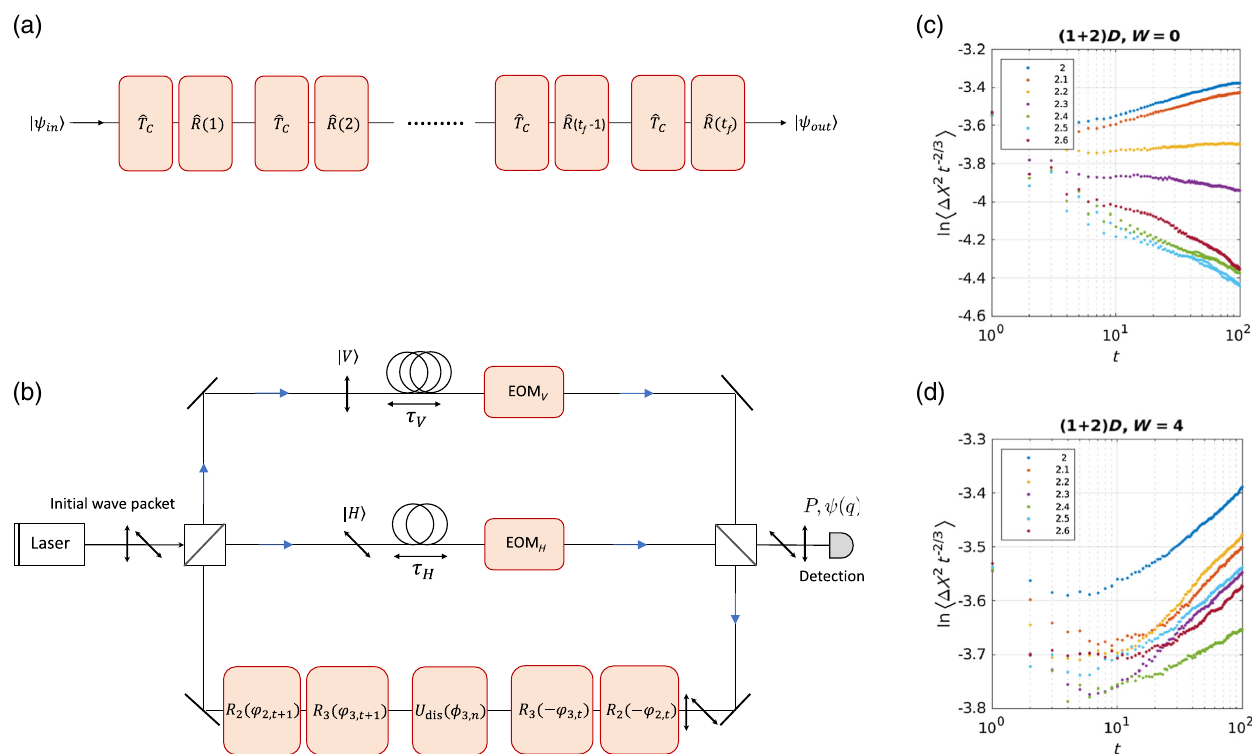
FIG. 3. (a,b) Blueprint of an optical linear network simulating the topological surface states of a 4 D quantum Hall insulator in the quantum-walk setting. The feedback loop is built of the step operator ˆ R ˆ U R † (lower arm) — for details, see main text. To the left and right of the loop, source and detection units are connected. ð t Þ ¼ R t t dis þ 1 The source consists of a laser and a polarizing beam splitter (PBS), allowing for the preparation of the initial state. The passage to the detection unit can be activated by the dynamically tunable EOMs following the fiber lines of the step operation. In the detection unit, photons are registered by an avalanche photodiode (APD). (c,d) Numerical simulations of wave-packet spreading for trivial and topological quantum walks, here for varying incommensurate frequencies. The latter are chosen as ω 2 ¼ C several values 2 . 0 ≤ C ≤ 2 . 6 (see legends). Differences between the two systems become visible already after t ≳ 10 time steps: The topological metal (d) shows robust diffusion for all values of C , while a crossover from diffusive to subdiffusive dynamics is observed as C > 2 . 4 for the trivial metal